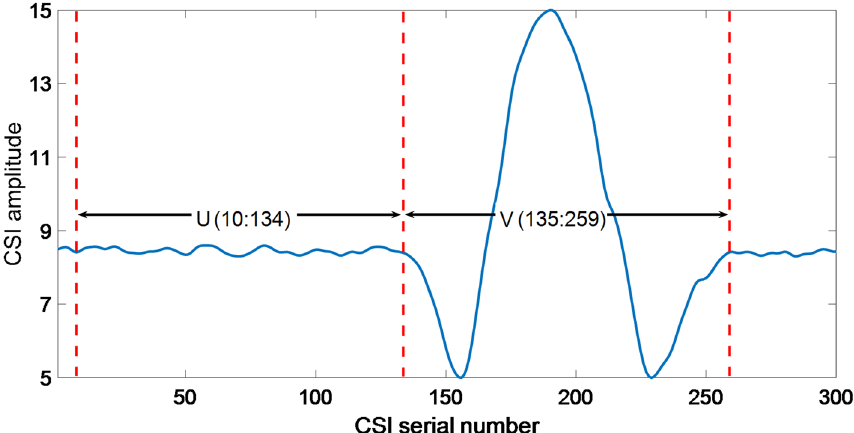
Fig. 5 Schematic of KL divergence